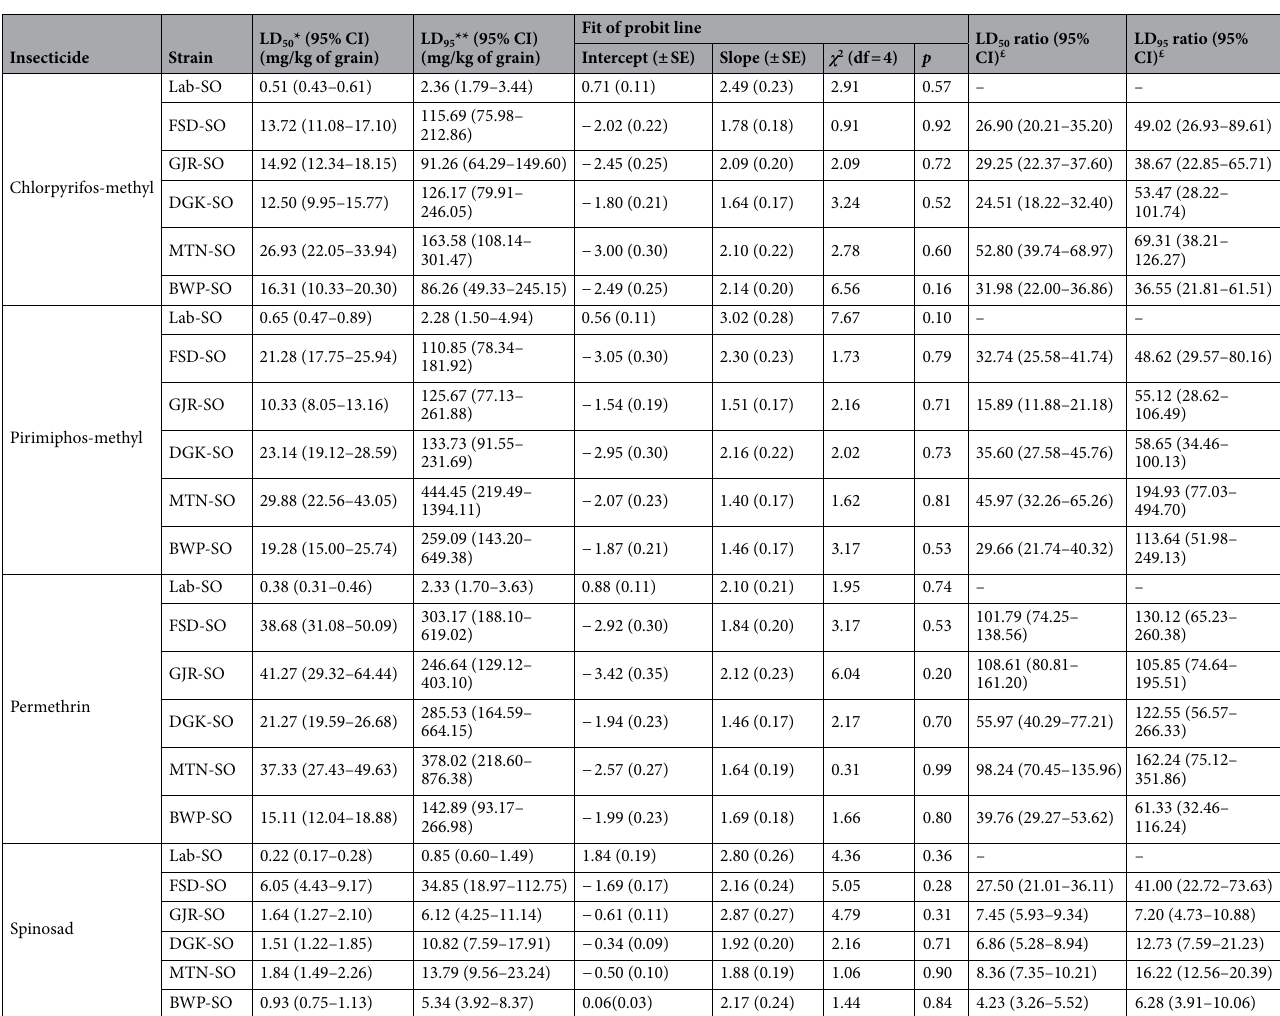
Table 1. Toxicity of insecticides in a laboratory and field strains of Sitophilus oryzae. *Lethal dose to kill 50% insects. **Lethal dose to kill 95% insects. £ Significant ratios based on the ratio test, i.e., 95% CI of the ratio did not include 1 32 . Ratio tests for analyzing presence of resistance to different insecticides in field strains of Sitophilus oryzae in comparison to the Lab-SO strain at LD 50 and LD 95